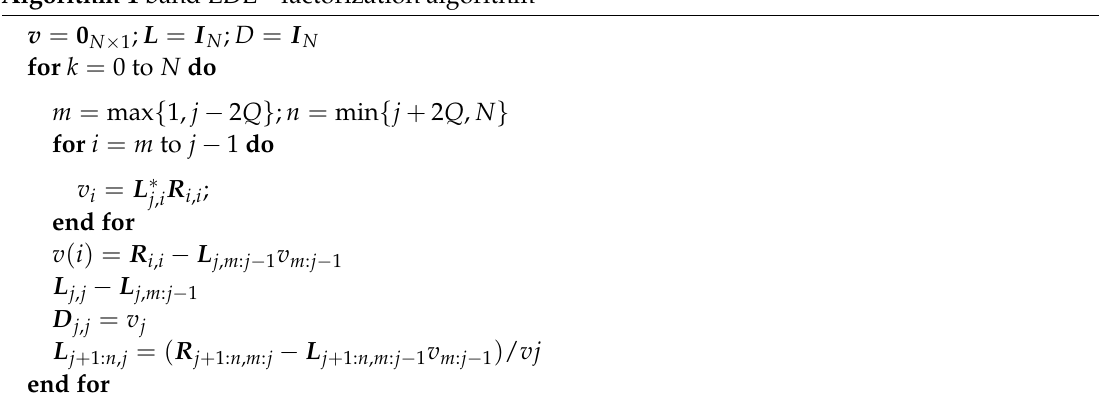
Algorithm 1 band LDL H factorization